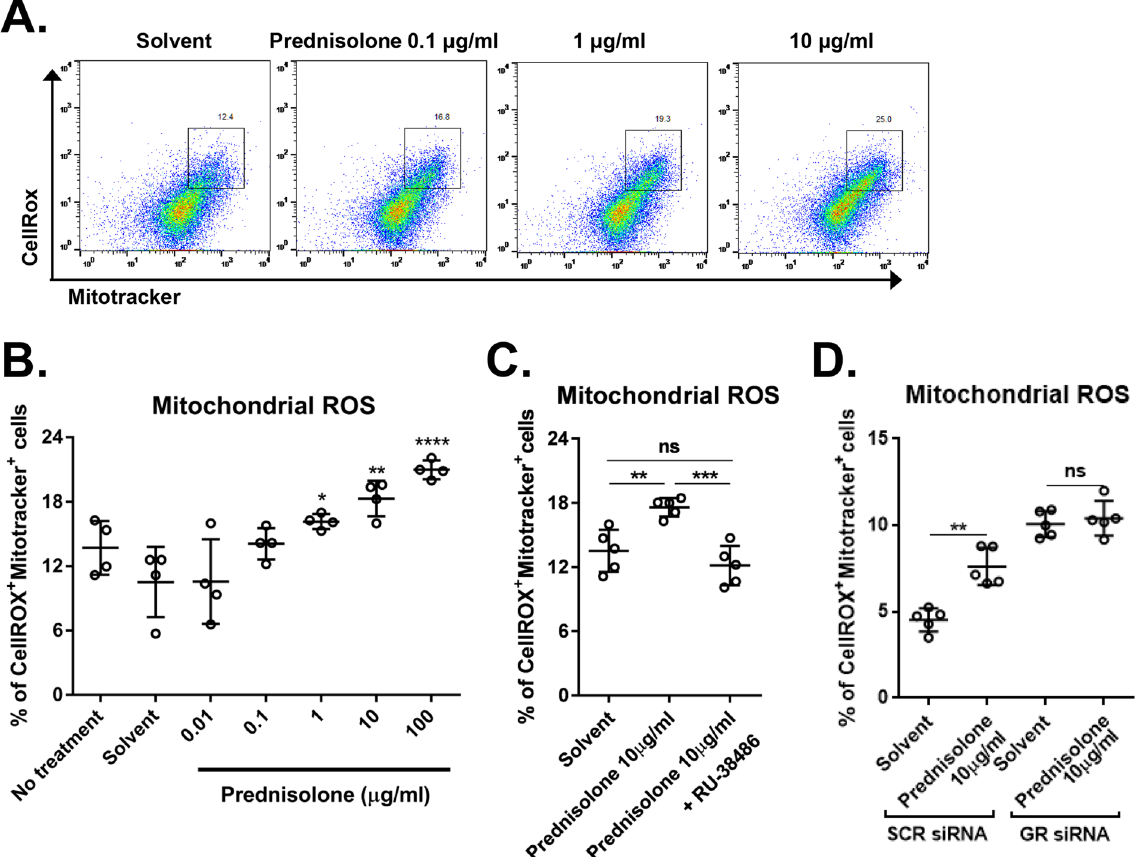
Figure 3. Effects of prednisolone on mitochondrial reactive oxygen species (ROS). ( A ) Representative flow cytometry plots for hCECs after staining with CellROX TM Deep Red and MitoTracker Green dyes. ( B – D ) Quantitative flow cytometry results for CellROX + MitoTracker + cells as a measure of mitochondrial ROS in hCECs treated with prednisolone. The glucocorticoid receptor (GR) antagonist RU-38486 was added to some cultures ( C ). The mitochondrial ROS was also measured in hCECs transfected with GR siRNA or control SCR siRNA ( D ). Data are presented as mean ± SD from at least four independent experiments. * p < 0.05, ** p < 0.01, *** p < 0.001, **** p < 0.0001, ns: not